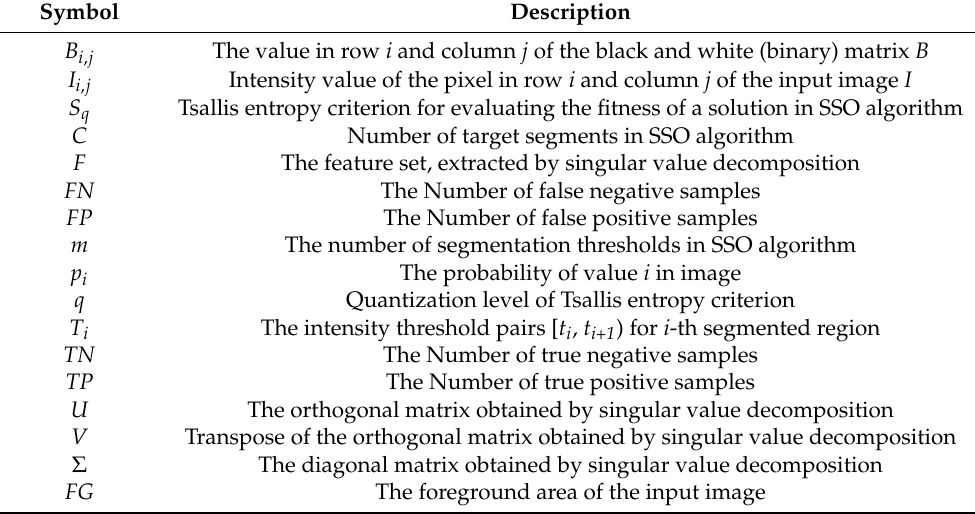
Table 2. Notations used in this